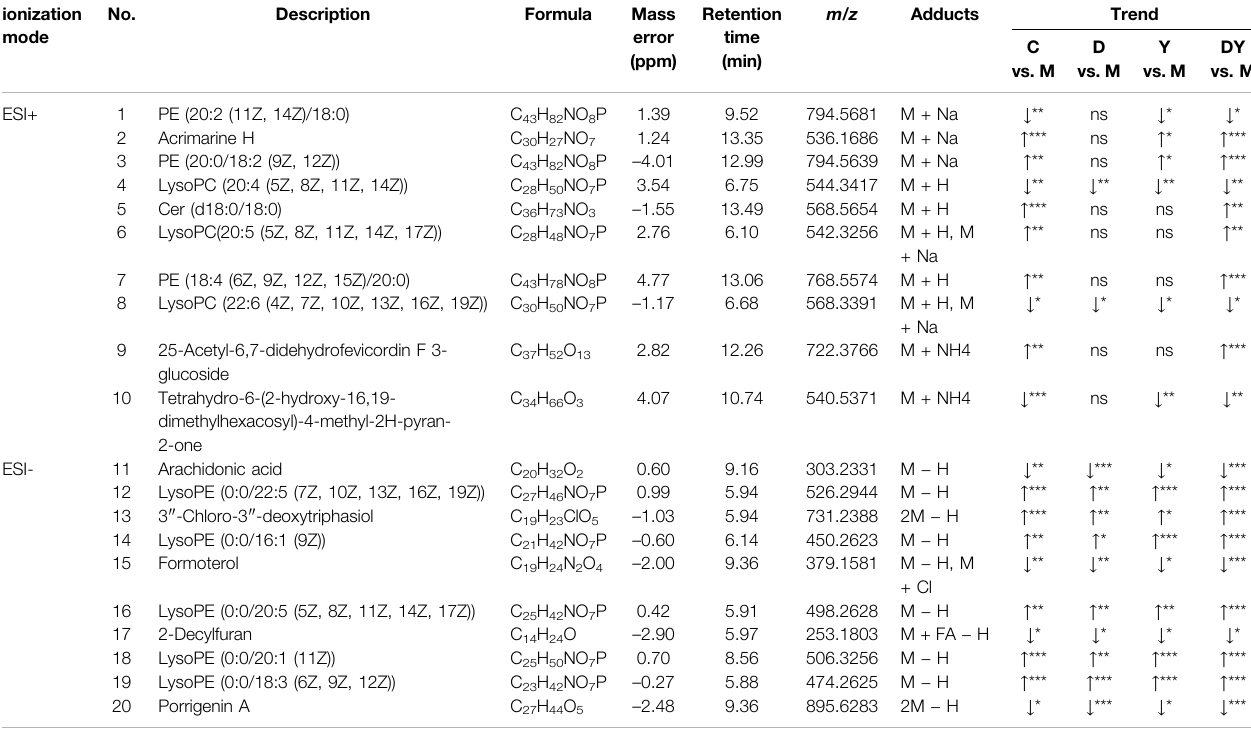
TABLE 2 | Identi fi cation of potential markers and their changing trends among different groups (C (cid:2) control, M (cid:2) model). ionization No. mode